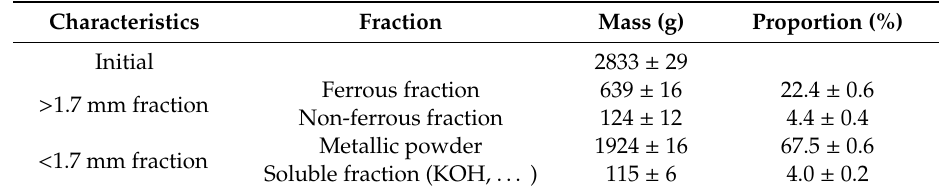
Table 3. Composition of the battery after separation by attrition and magnetic separation (physical